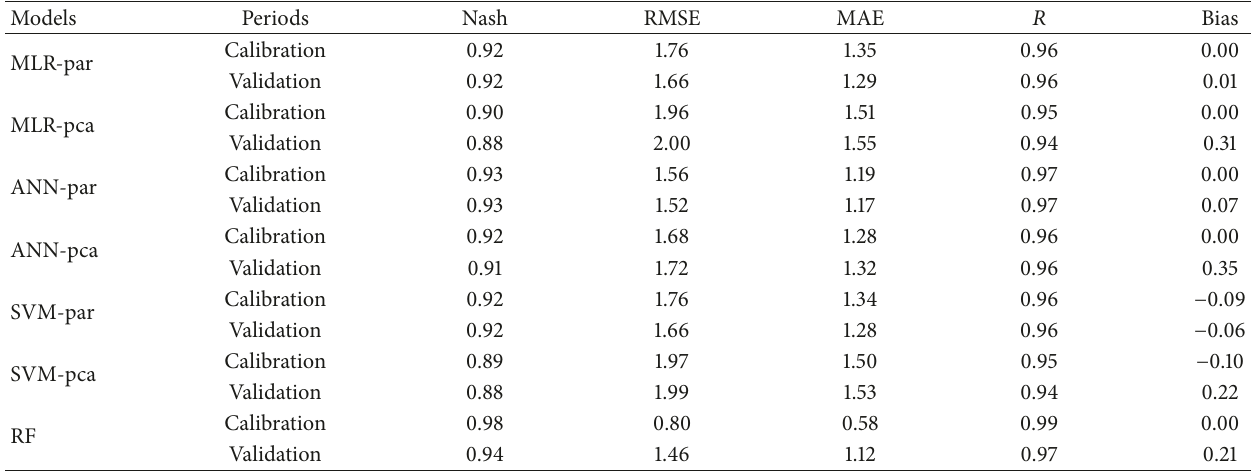
Table 2: Performance assessment for predictands in calibration and